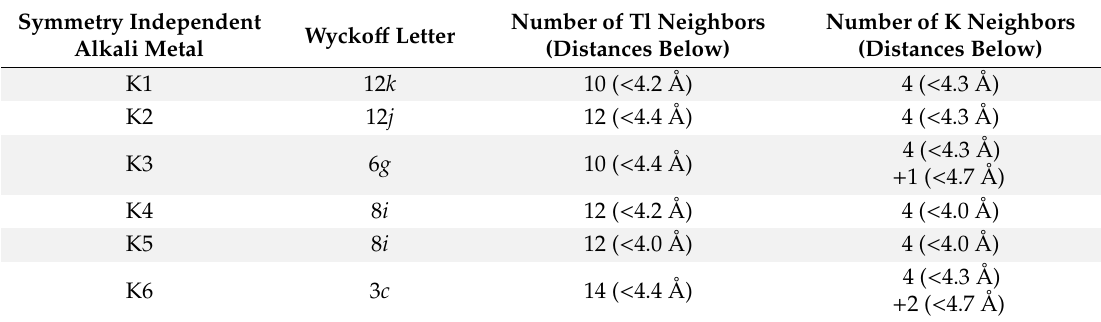
Figure 3. Unit cell and surroundings of the six symmetry inequivalent potassium positions in K 49 Tl 108 . The corresponding range of distances to the adjacent atoms as well as the Wyckoff letters are given in Table 2. Table 2. Surrounding atoms of the symmetry inequivalent potassium positions in K 49 Tl 108 (space group Pm -3).